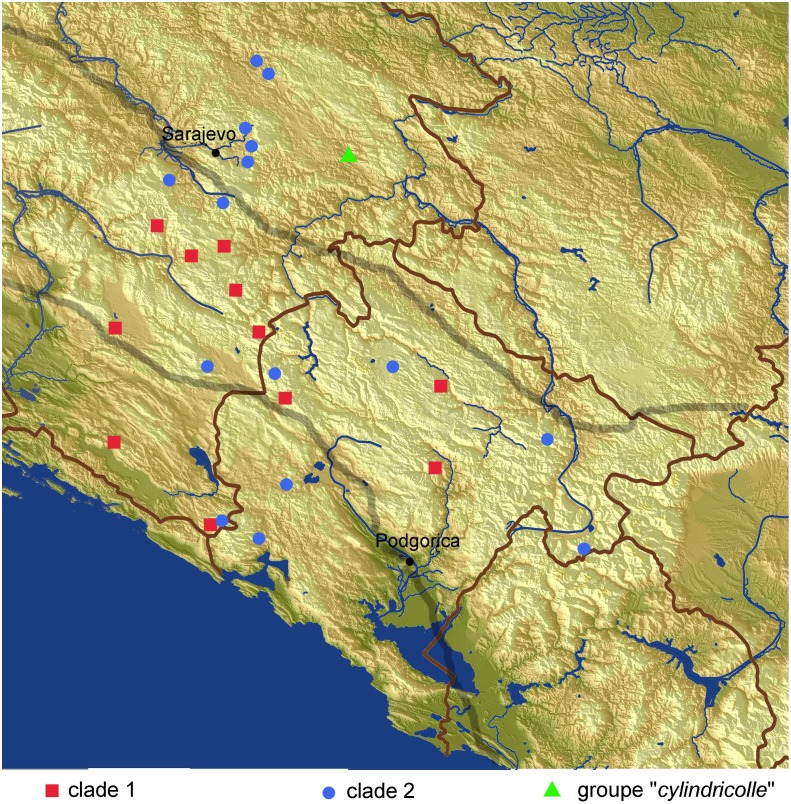
Distribution of Anthroherpon species included in the phylogenetic reconstruction obtained with BEAST (Fig 2).Different colours and symbols denote main clades of the phylogenetic tree. Thick grey lines show delimitation of the Dinaric karst in three main belts, from the southwest to northeast: the Low coastal Adriatic karst, the High mountain karst, and the Low continental interior karst [67].